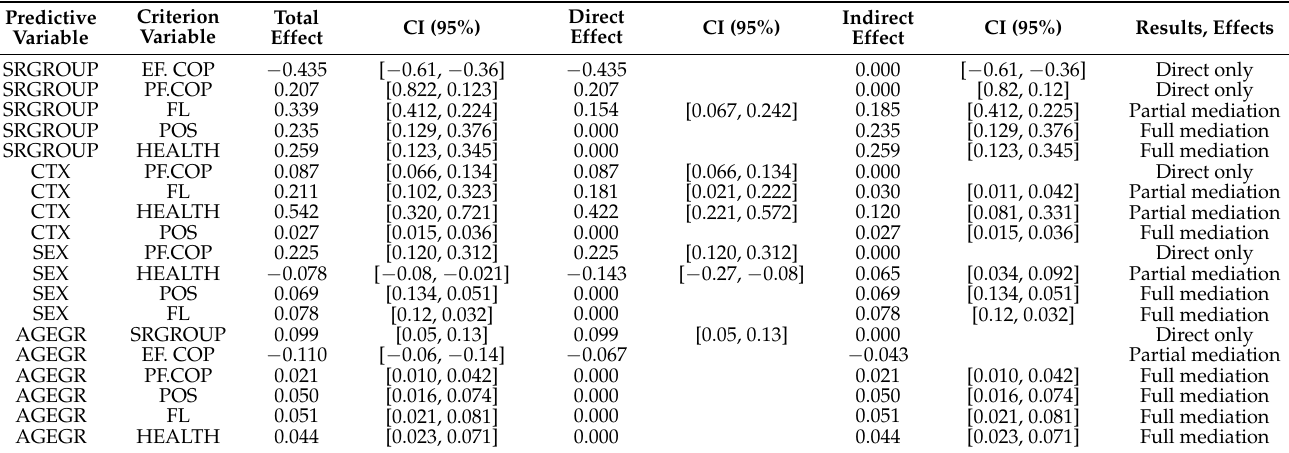
Table 3. Total, direct, and indirect standardized effects of the